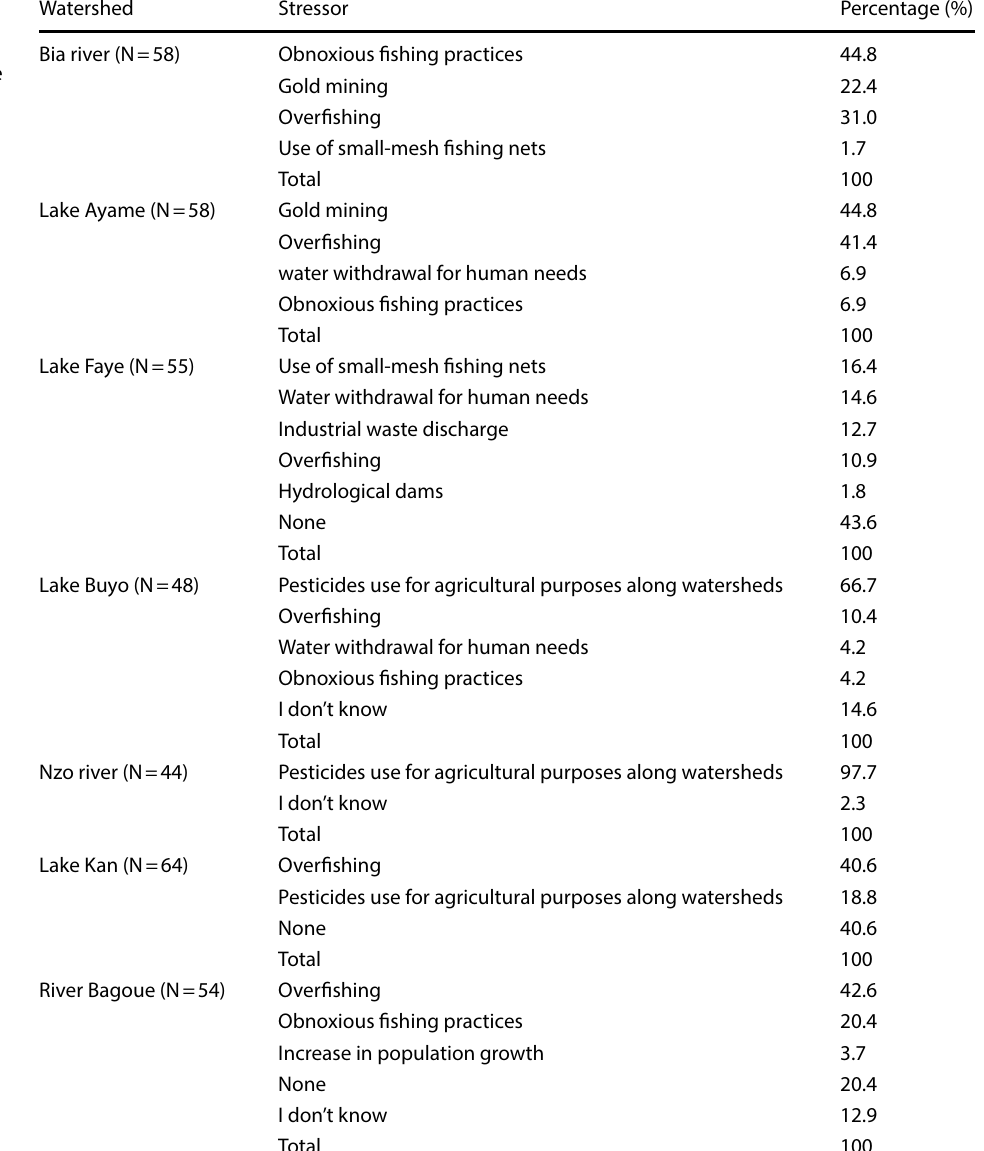
Table 4 Anthropogenic activities threatening Ivorian freshwater fish biodiversity according to fishermen of the watersheds